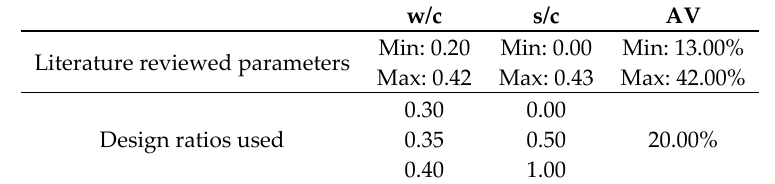
Table 1. Main PC parameters for design.